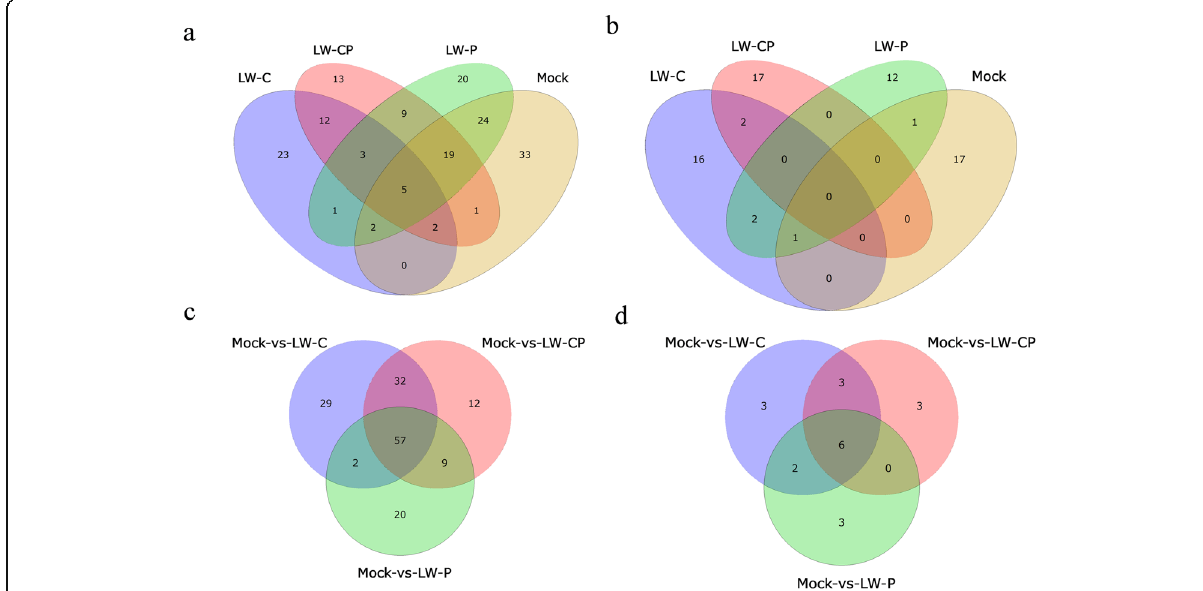
Fig. 9 Venn diagrams illustrating the number of expressed milRNAs from mycovirus-infected Botryosphaeria dothidea LW-Hubei strains. a The unique and commonly expressed known milRNAs and b novel milRNAs in the four libraries (LW-CP, LW-C, LW-P and Mock). Illustration of the unique and commonly differentially expressed c known milRNAs and d novel milRNAs detected in three comparisons of LW-CP/Mock, LW-C/ Mock and LW-P/Mock. Pair-wise interactions identified in comparisons between W-CP vs. LW-C, LW-CP vs. LW-P, LW-CP vs. Mock, and LW-C vs. LW-P libraries. Blue oval, LW-C; green oval, LW-P; light pink oval, Mock; pink oval,